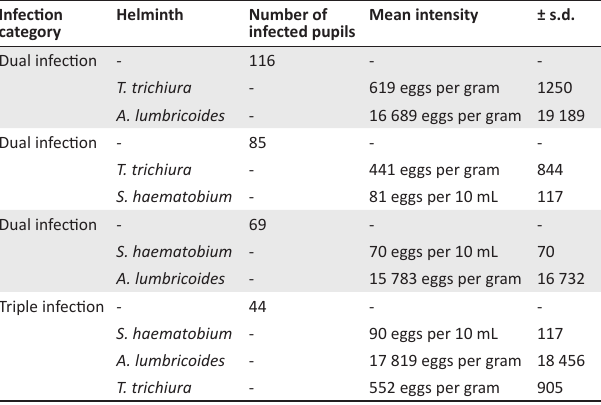
TABLE 4: Intensity of infection amongst dual- and triple-infected pupils from 18 Ugu district primary schools ( N = 1044). Infection Helminth category